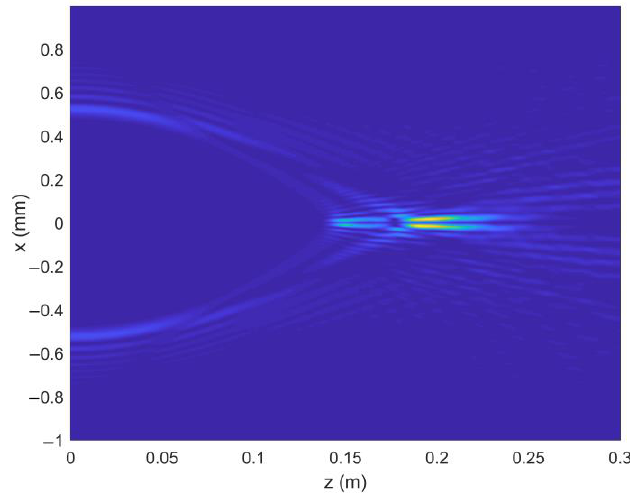
Figure 1. The intensity pattern and phase distribution of the left-hand circular polarized (LHCP) component at different distances. ( b , c ) show the intensity pattern for z = 100 mm and z = 200 mm, respectively; ( e , f ) show the phase distribution for z = 100 mm and z = 200 mm, respectively. The intensity pattern and phase distribution of the initial beam are also shown in ( a , d ).